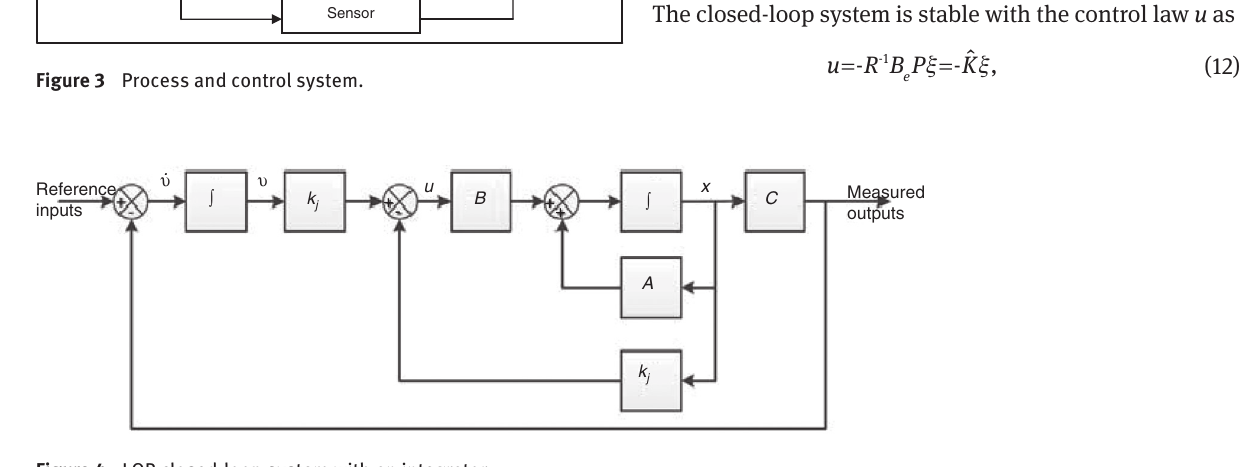
Figure 4 LQR closed-loop system with an